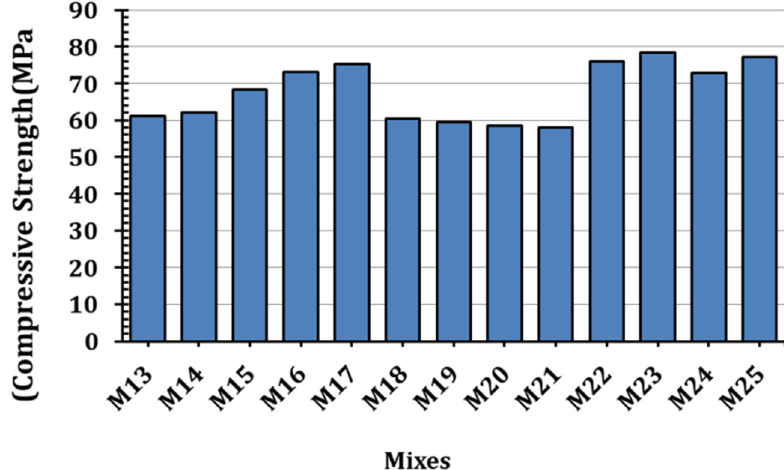
Figure 4: 28 - Day compressive strength test results of HSC